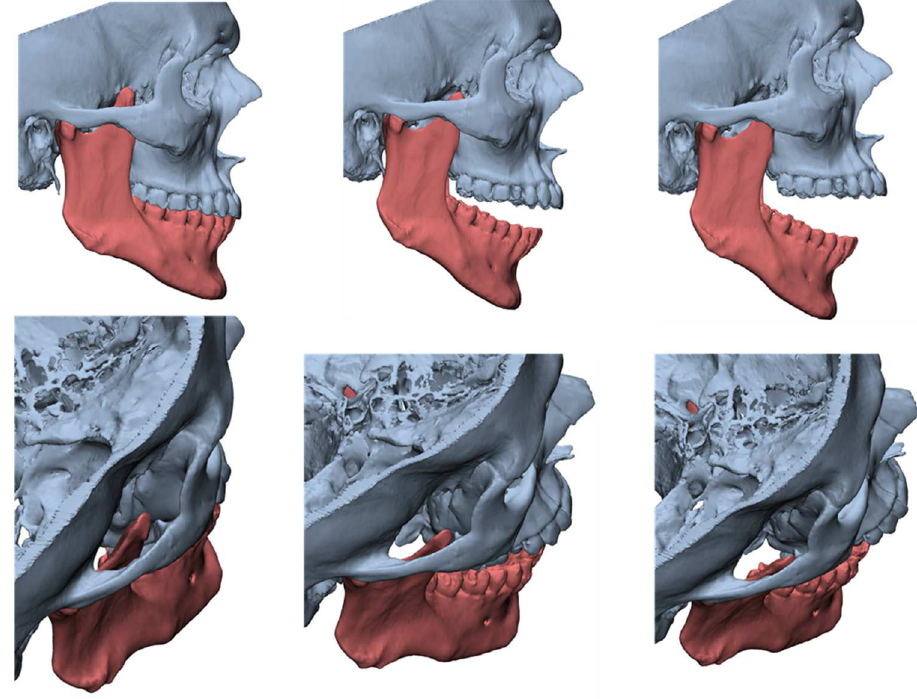
Figure 6. Cinematic 3D reconstruction (Mimics, Materialise NV., Leuven, Belgium) showing the established right JD.